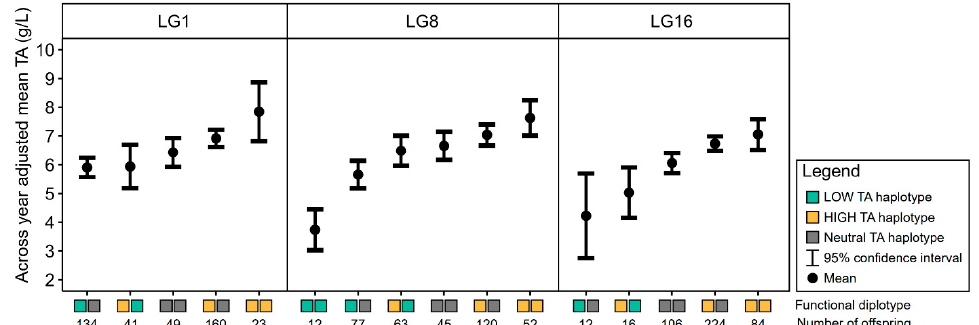
Figure 1. Means and 95% confidence intervals for across-year adjusted titratable acidity (TA) for offspring functional diplotypes at the LG1, LG8, and LG16 QTLs. Low-TA haplotypes were 1E, 1F, 8I, and 16H (corresponding to designations in Table 2). High-TA haplotypes were 1A, 8A, 8B, 8C, 16A, and 16B (corresponding to designations in Table 2). The number of offspring with a given functional diplotype is listed below each functional diplotype.